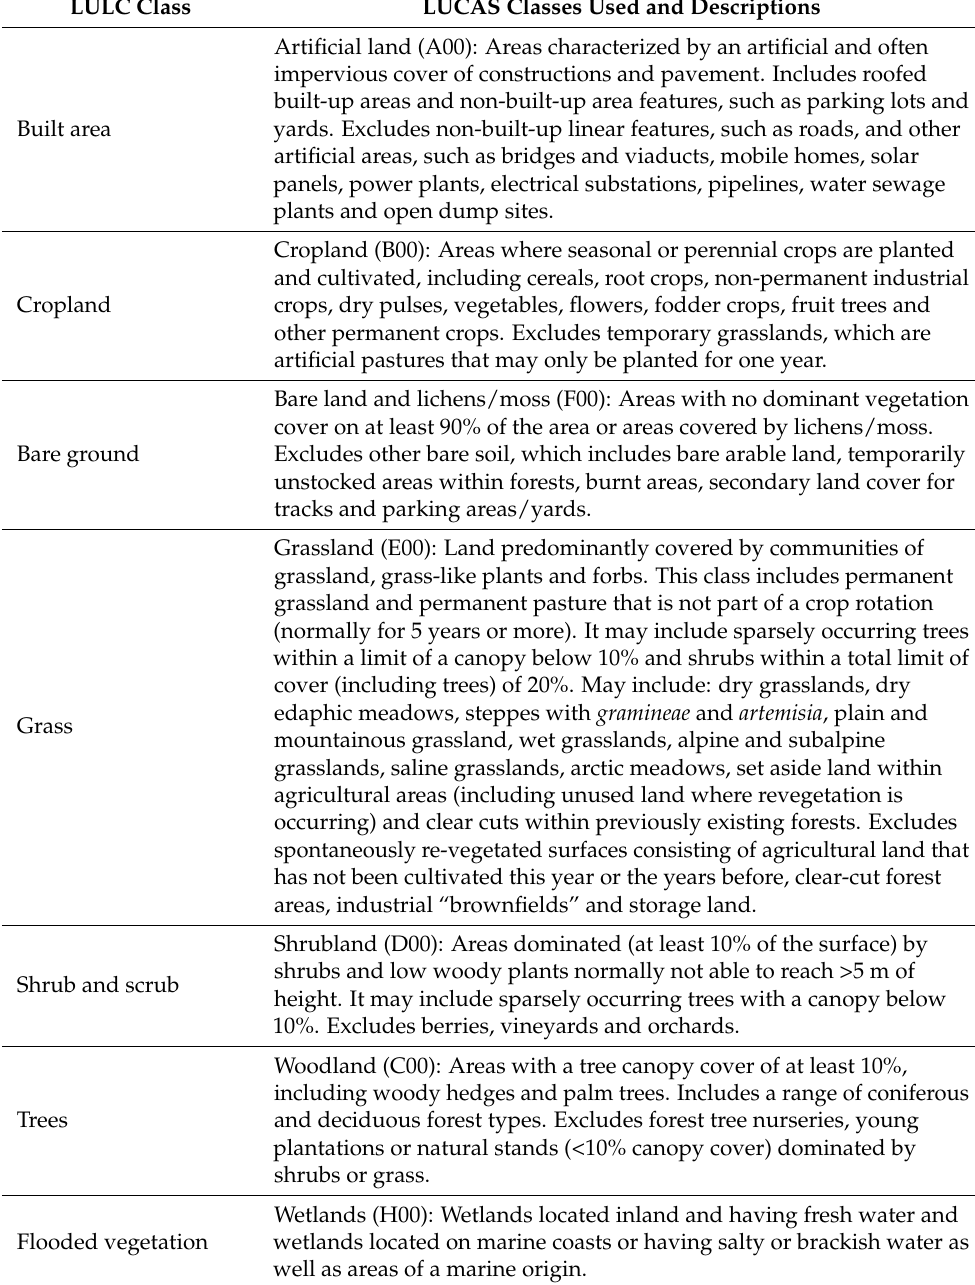
Table 2. Classification typology of the LUCAS data used for regional (European) validation of global LULC maps in this